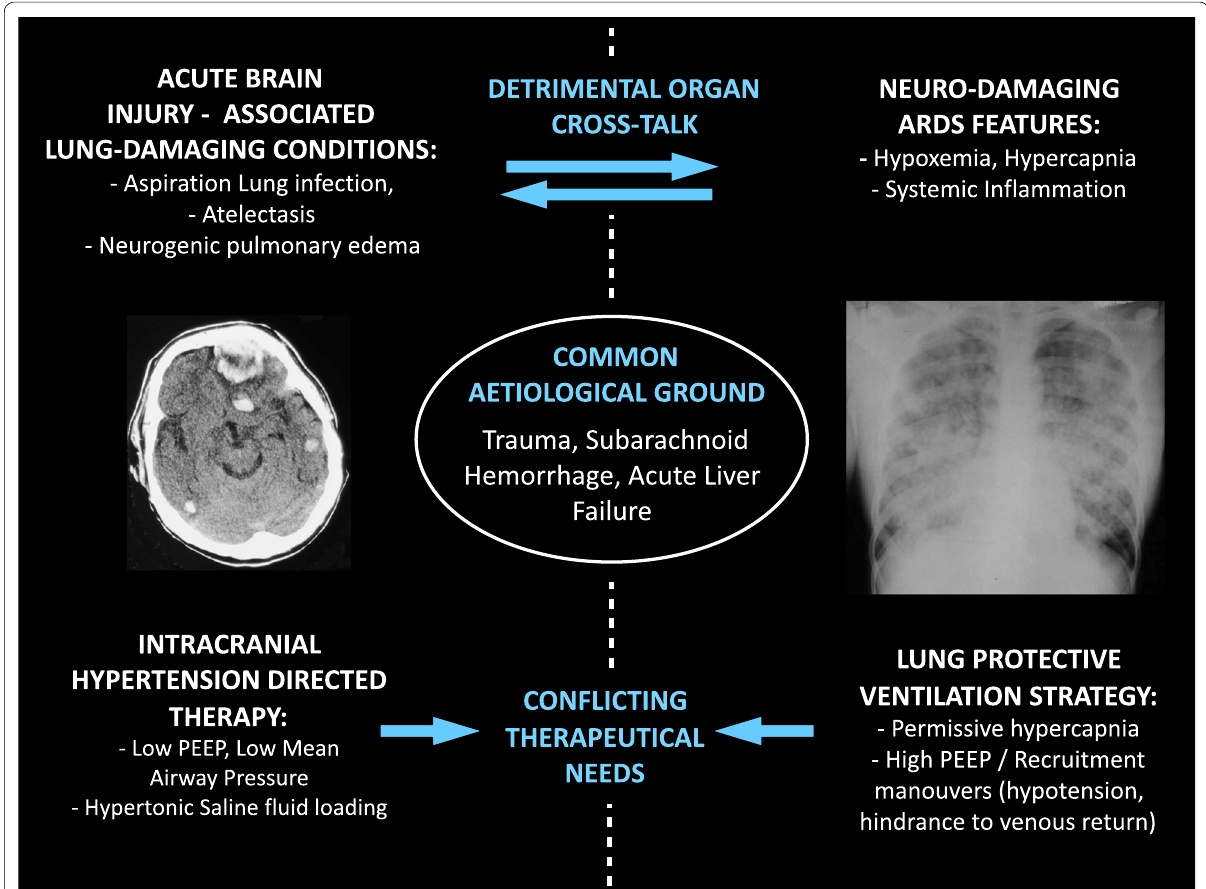
Fig. 1 Potential pathophysiological interactions between severe brain injury and severe lung injury, and their conflicting therapeutical needs. Severe brain injury and severe lung damage may ensue as consequence of the same noxious agent (for example in severe multiple trauma or severe liver failure), but also one be the cause of the other (e.g., neurogenic pulmonary edema in subarachnoid hemorrhage, or lung aspiration and infection in a comatous patient). Indeed, once coexisting, disease of one organ can negatively affect the other, in a harmful organ cross-talk (e.g., hypoxemia can worsen brain damage). Finally, some therapeutical interventions directed at protecting one organ may have detrimental effects on the other (e.g., mechanical ventilation strategies can either reduce systemic mean arterial pressure, decrease cerebral venous return, or cause cerebral vasodilation, thus inducing a worsening of intracranial hypertension and reducing the cerebral perfusion